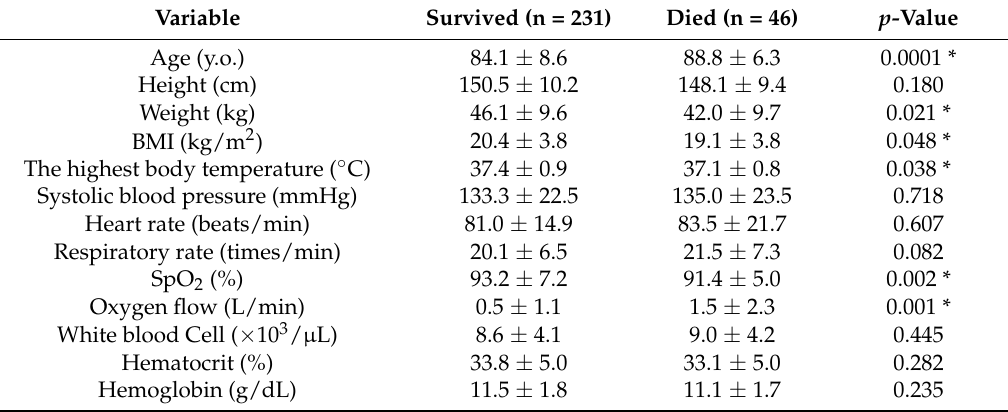
Table 4. Relationship between numerical data and prognosis (univariate